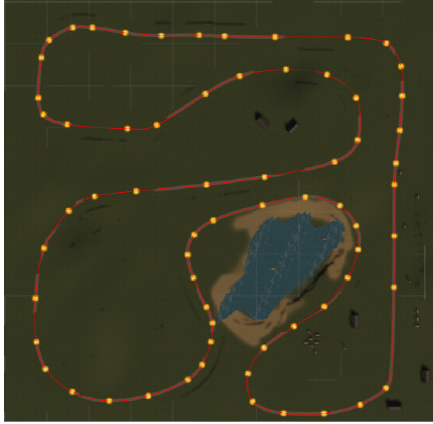
Figure 5. One of the paths (red line) viewed from the top. Each path is constituted by a series of nodes (highlighted in orange) that are interpolated in real time. Other paths, dedicated to other users, run in parallel.